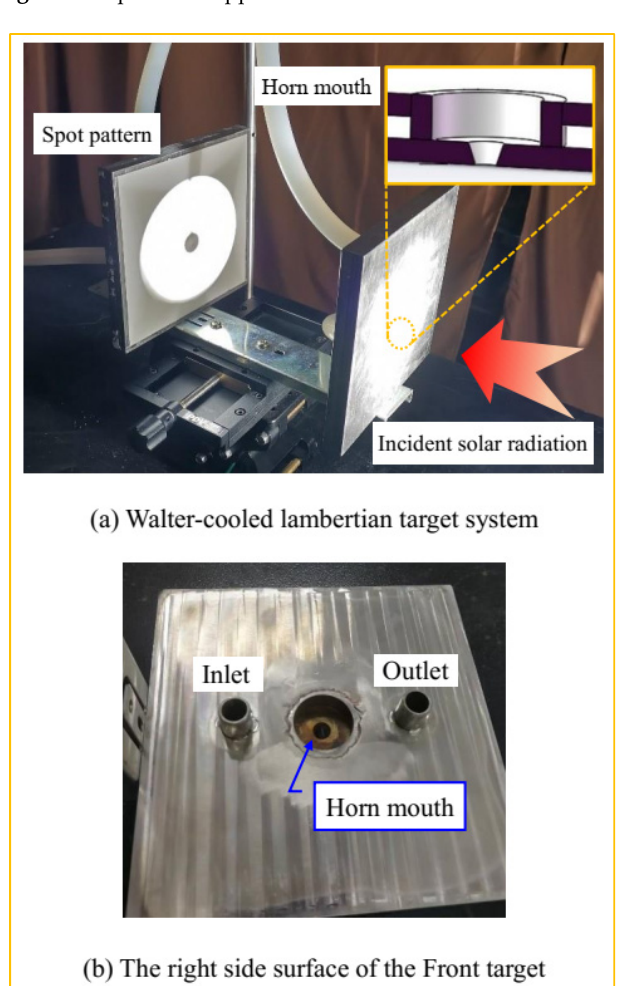
Figure 3. Water-cooled Lambertian targets.